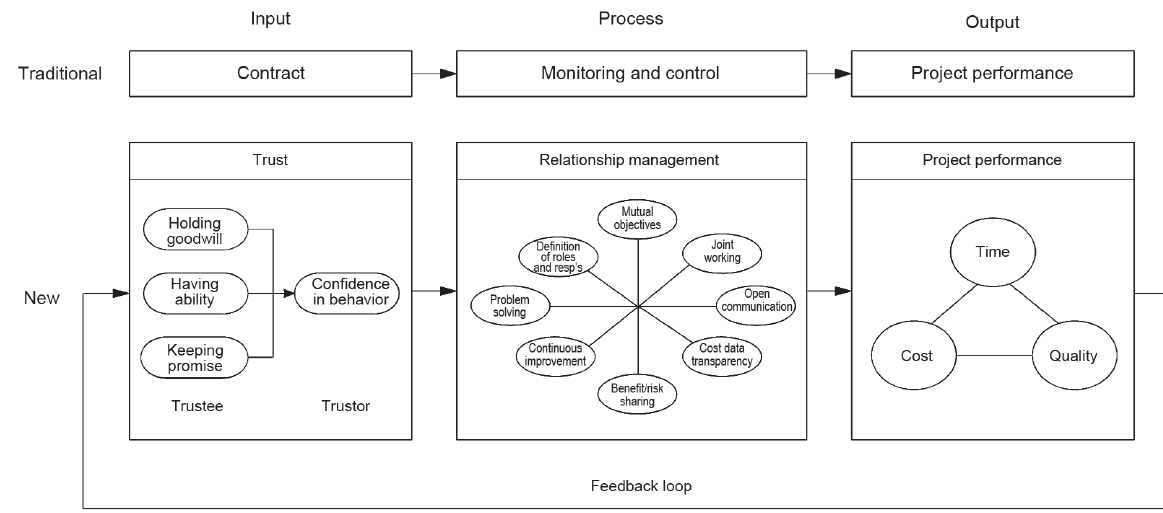
Fig. 1. Trust-based management versus monitoring and control-focused